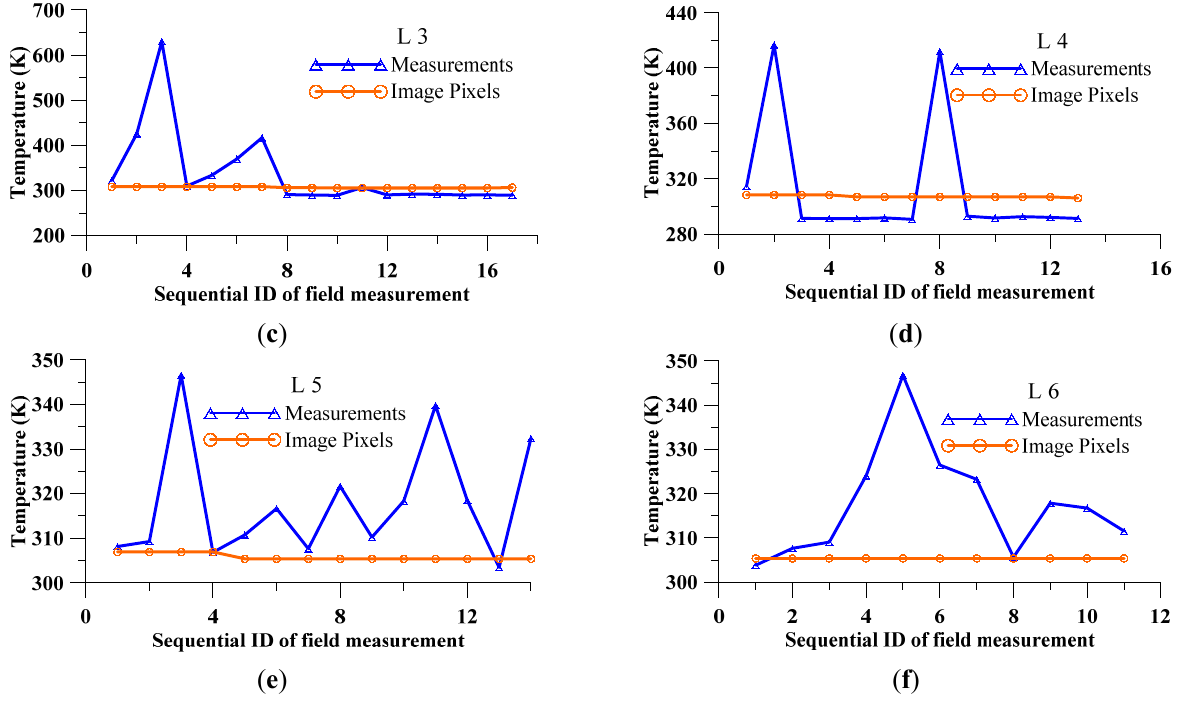
Figure 9. ( a – b ) Profiles of surface temperature values measured along transects (blue) and calculated from images (orange). Note: scale changes between